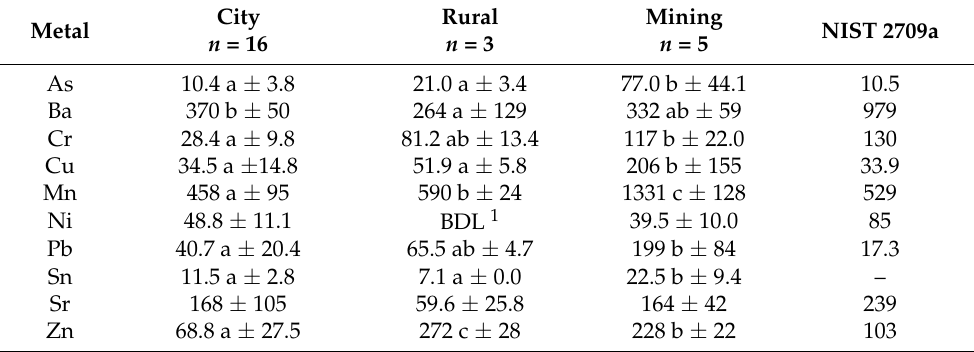
Table 1. Average metal concentrations (mg kg − 1 ) ± standard deviation in the soil of the three types of urban gardens and certified or reference values in the reference material. Different letters indicate significant differences at p < 0.05 (Mann–Whitney U test except As, Ba, Cu, Mn, and Zn by LSD test).